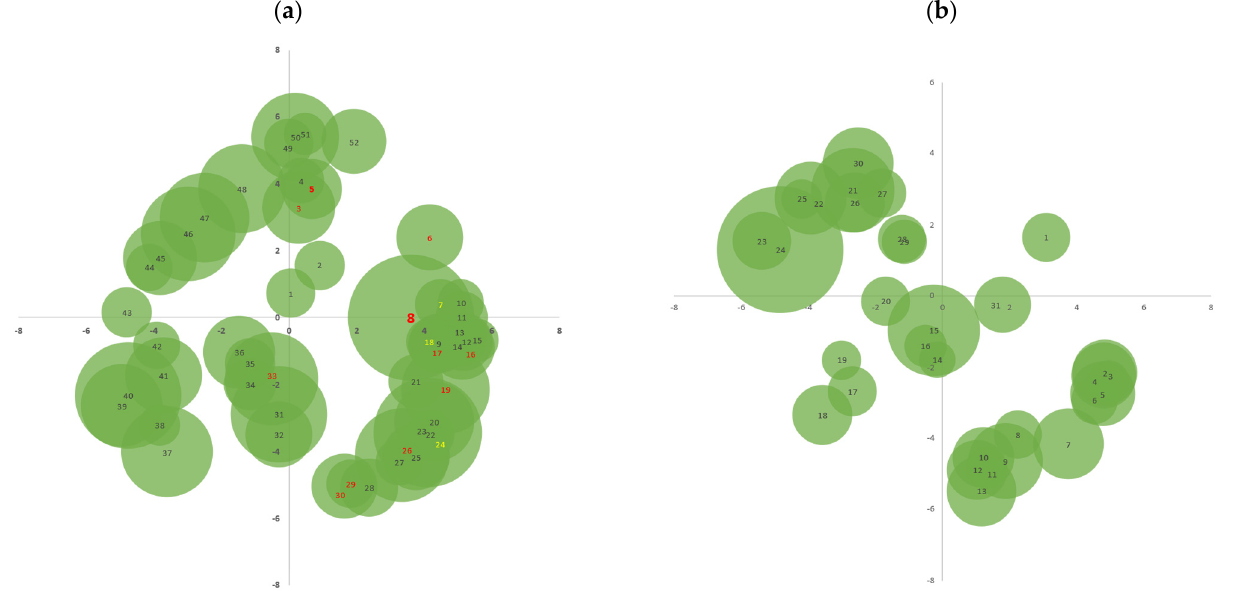
Figure 3. Distribution of the trees in the areas defined to select and collect the samples. ( a ) Parcel 1; and ( b ) Parcel 2.